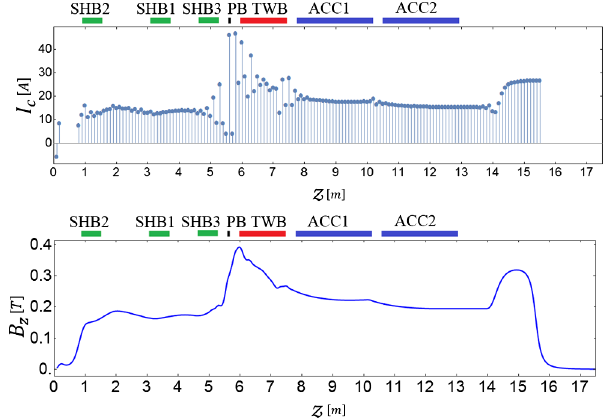
FIG. 12. The current distribution of the magnetic coils (top panel) and the magnetic field profile (bottom panel) in the focusing channel from the beam waist designed for the CLIC drive beam injector.